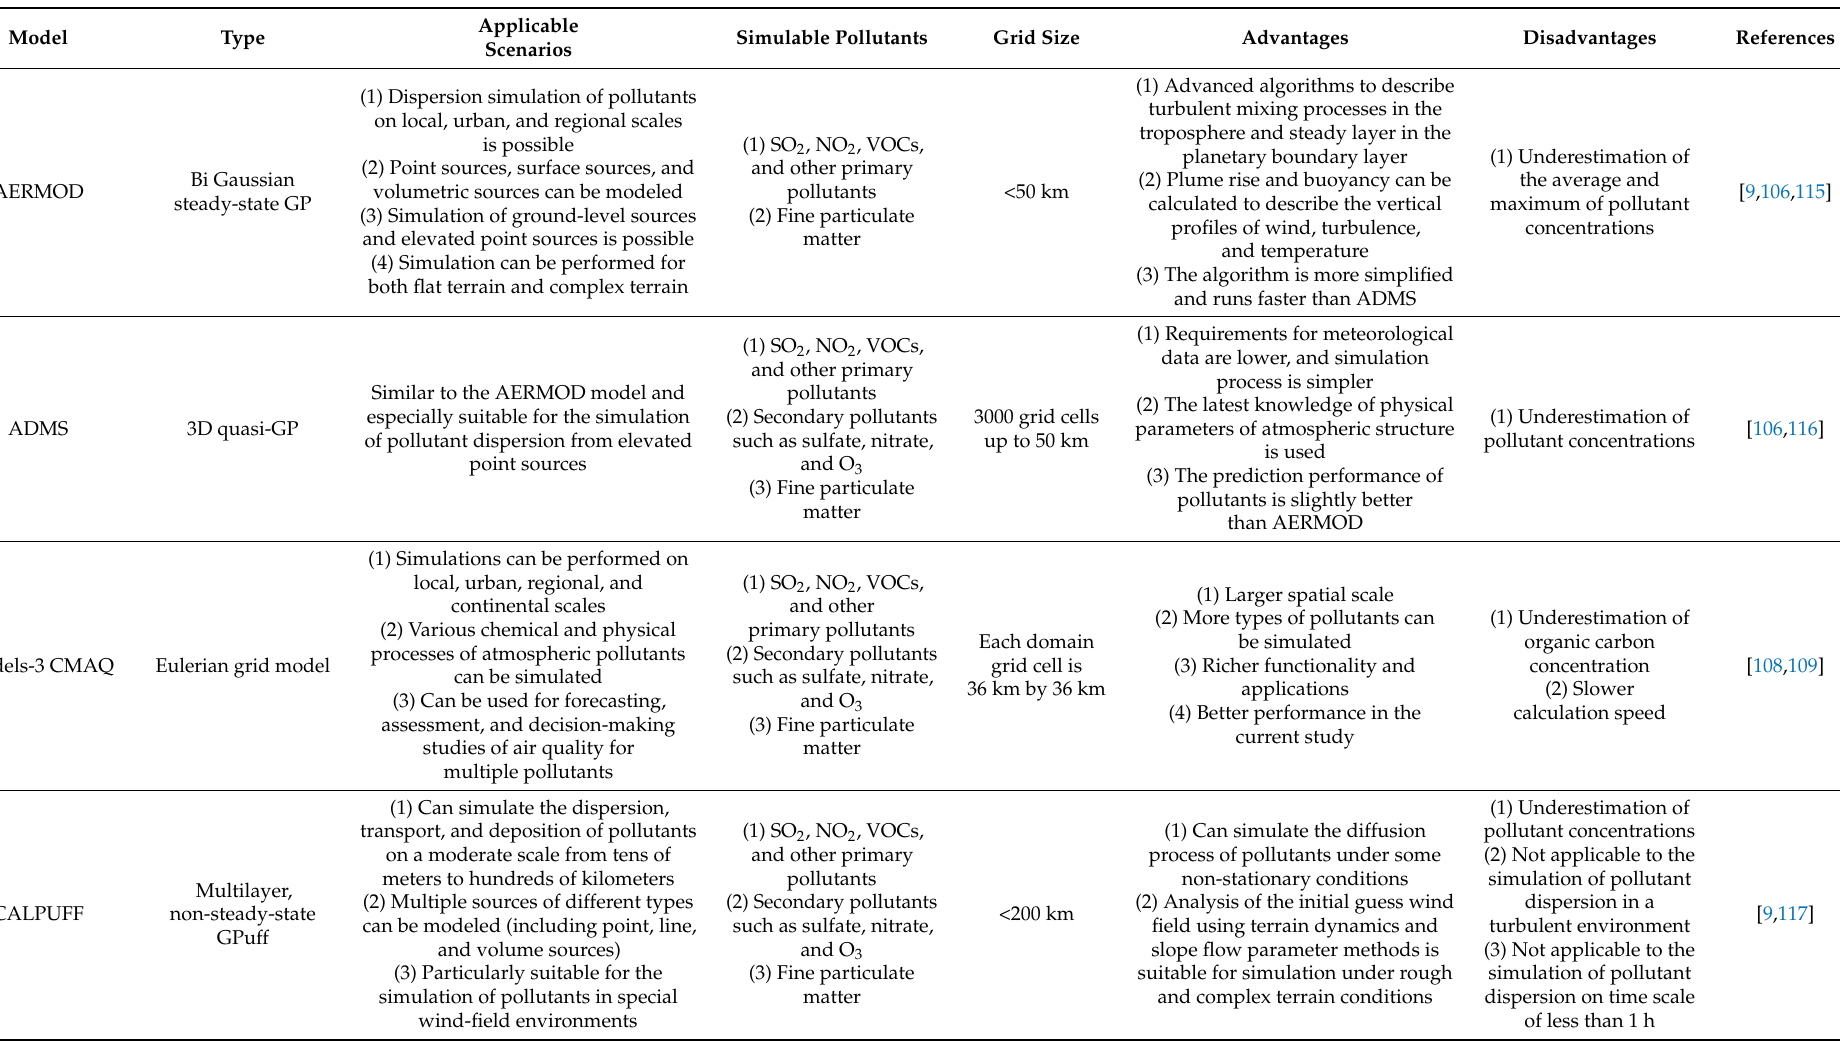
Table 4. VOC vertical distribution